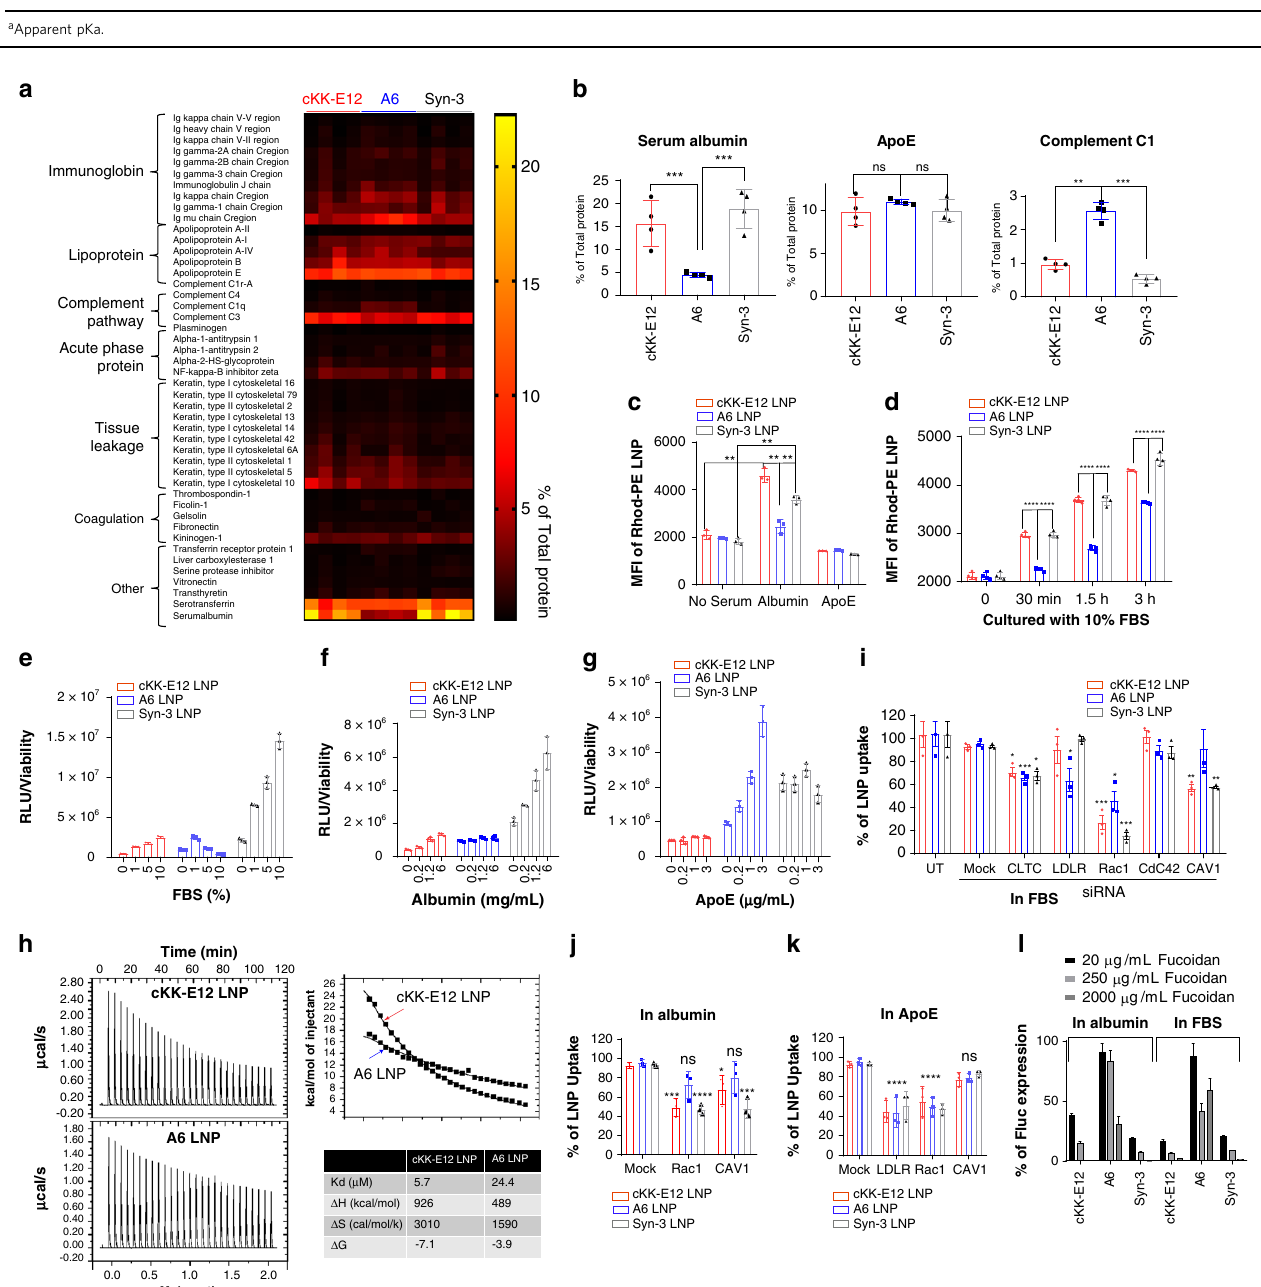
Fig. 2 Protein corona facilitates the binding and internalization of cKK-E12 containing LNPs to primary hepatocytes. a Proteomics analysis of protein coronas isolated from three types of LNPs ( n = 4/group). Quanti fi cation of % of major proteins are shown in ( b ). c , d Uptake of Rhod-PE labeled LNPs in primary hepatocytes in the presence or absence of selected proteins (n = 4/group). One-way ANOVA. e , g Expression of luciferase mRNA 6 h post transfection of primary hepatocytes in different protein pretreatment conditions ( n = 3/group). h ITC data estimates the binding between LNPs and albumin. One-wat ANOVA. i – k siRNA knockdown of certain endocytosis proteins demonstrates the mechanisms of endocytosis of different LNPs in the presence or absence of serum proteins ( n = 3/group). Student ’ s T-test comparing to Mock group. l The function of albumin in mediating the endocytosis